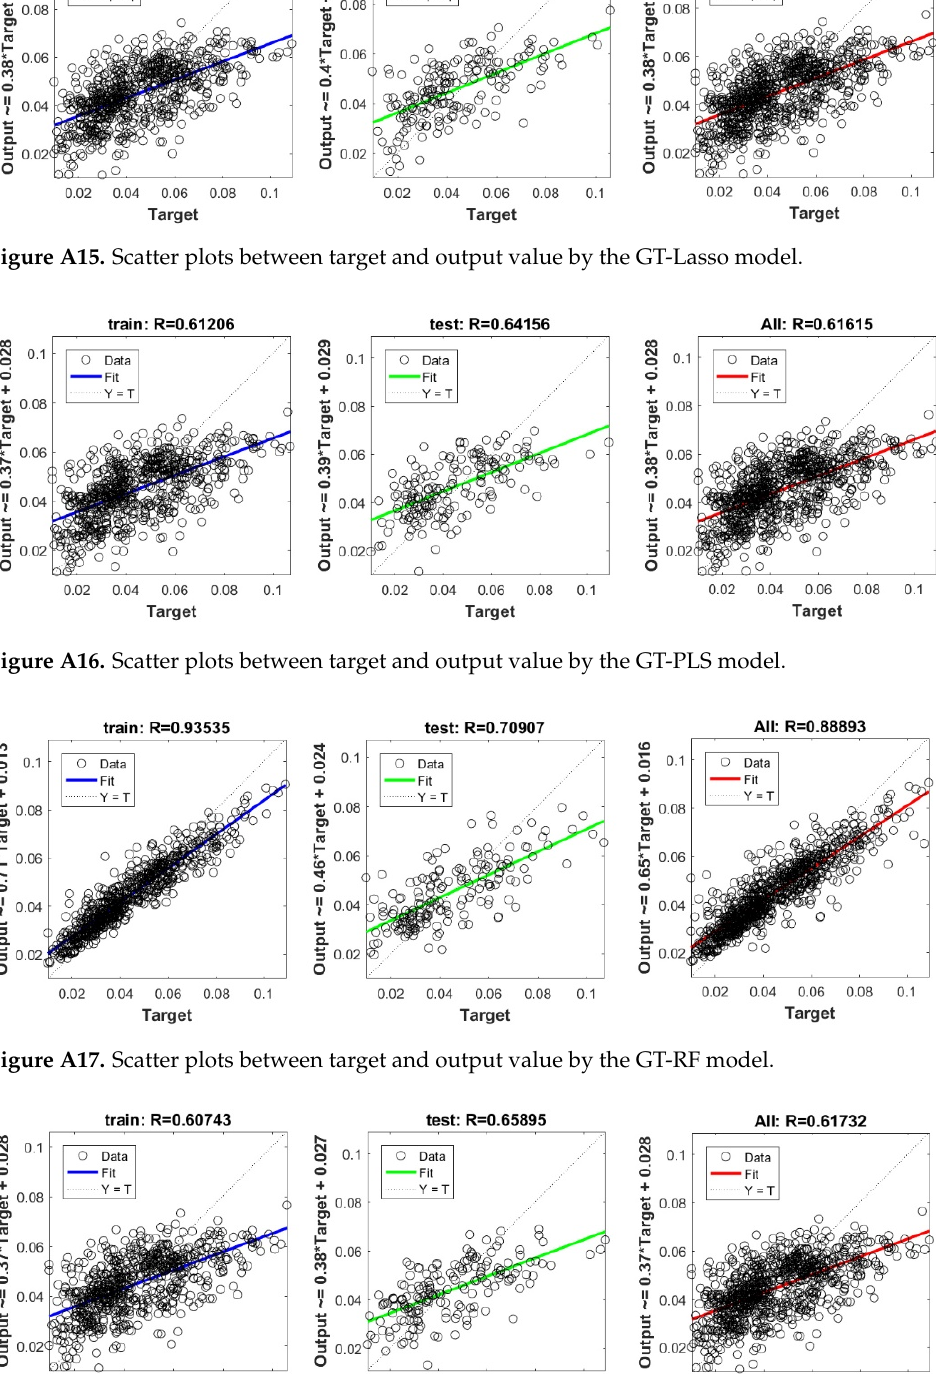
Figure A18. Scatter plots between target and output value by the GT-Ridge model.